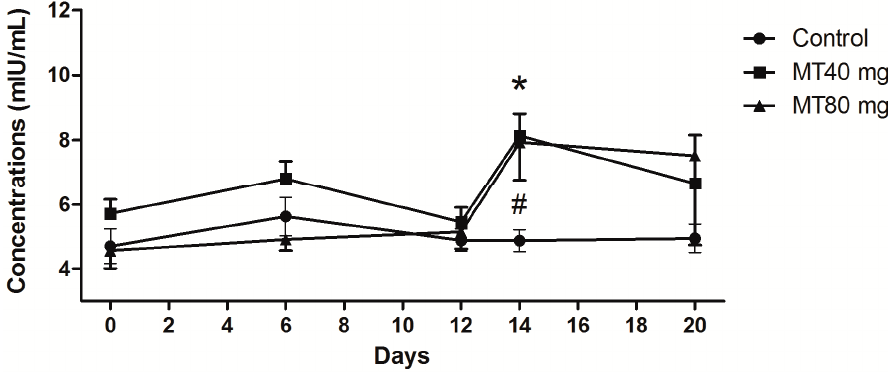
Figure 3. LH concentrations throughout the study period. Day 0: CIDR insertion; Day 6: CIDR substitution; Day 12: CIDR removal; Day 14: insemination; Day 20: embryo recovery. In melatonin-treated animals, the highest LH values were observed on Day 14, while in the control group, LH levels were stable during the process. Values are given as the mean ± S.E.M. The error bar is extended above and below at each time point in the MT40 mg group and MT80 mg group, respectively. “ * ” or “#” mean p <